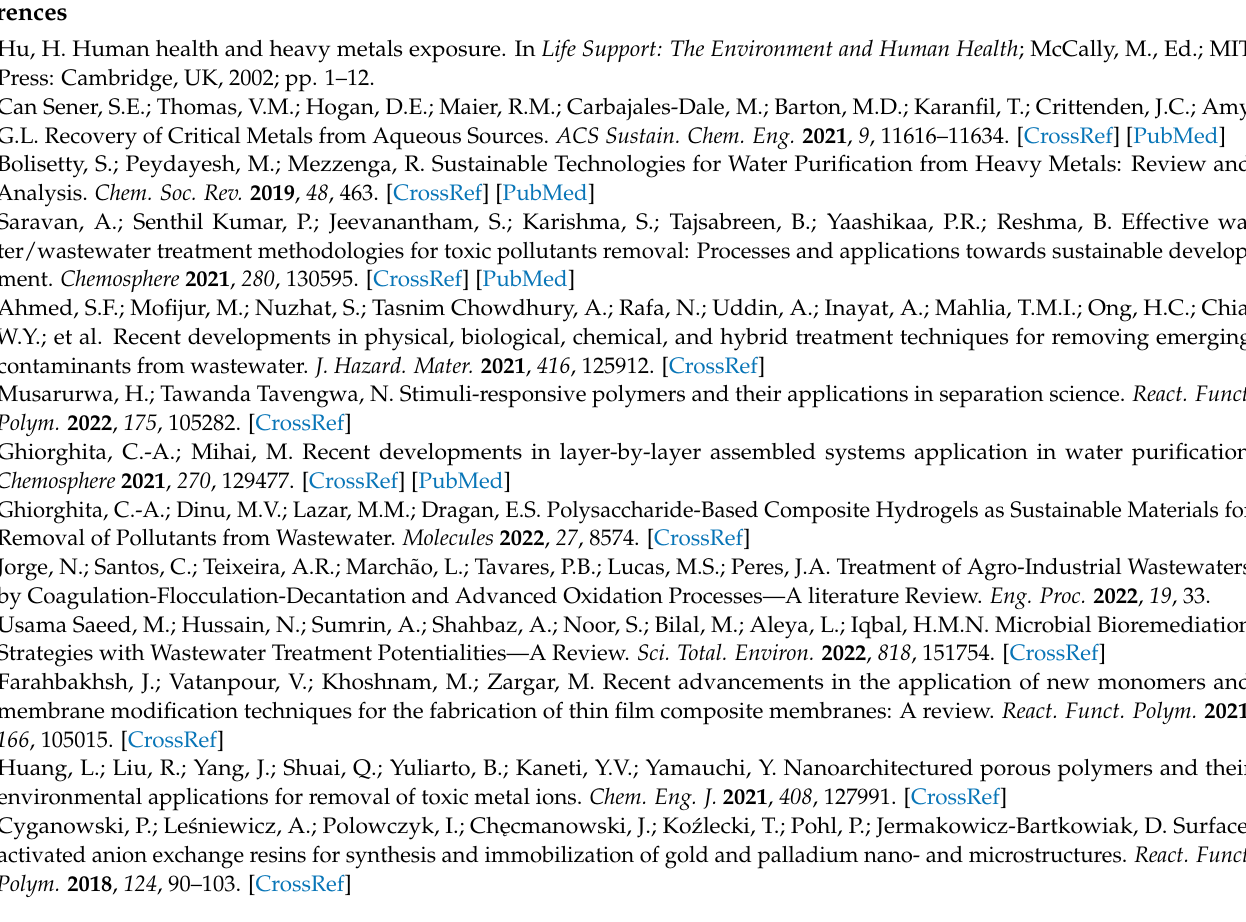
Table S2: Zn(II) Imprinted Polymeric Solid Phase Extractors. Table S3: Selective extraction of Co(II) ions. Table S4: Selective extraction of Fe(III). Table S5: Fe(III) Imprinted Polymeric Solid Phase Extractors. Table S6: Selective extraction of Hg(II). Table S7: Selective extraction of Cr(III) and Cr(VI). Table S8: Sorption of other transition metal ions by IIPs. Table S9: Selective sorption of Ag(I), Au(III), and Pd(II) ions by IIP materials. Table S10: Selective sorption of Ga(III), In(III), and Pb(II) ions by IIP